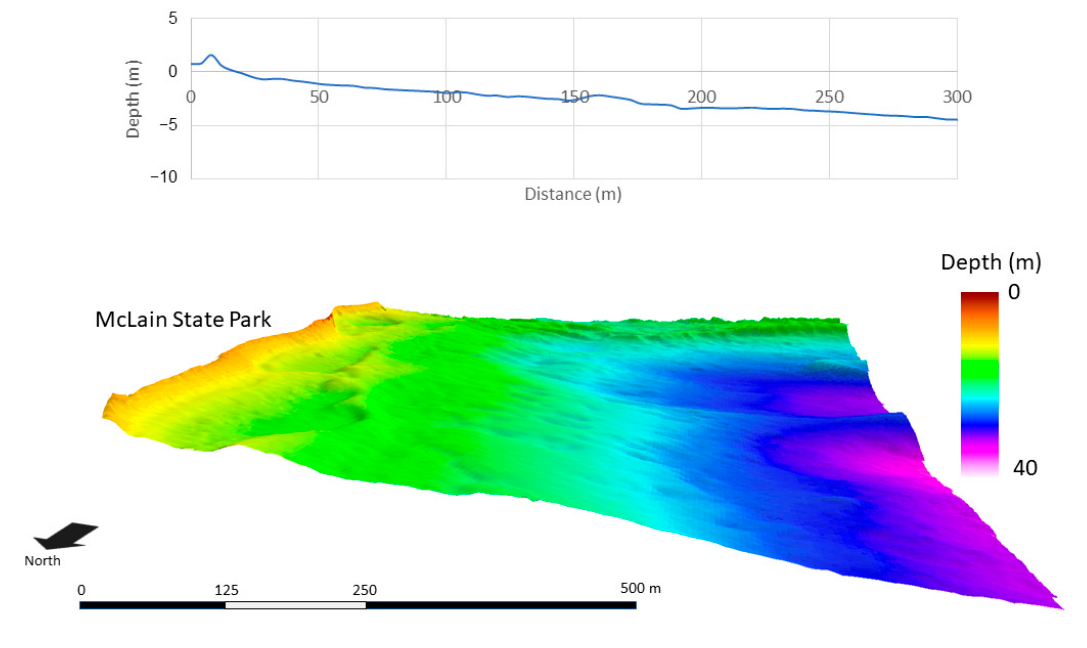
Figure 6. Average bathymetric profile of three 300-m transects ( top ), and area bathymetry (4-m resolution) of Lake Superior ( bottom ) at McLain State Park.